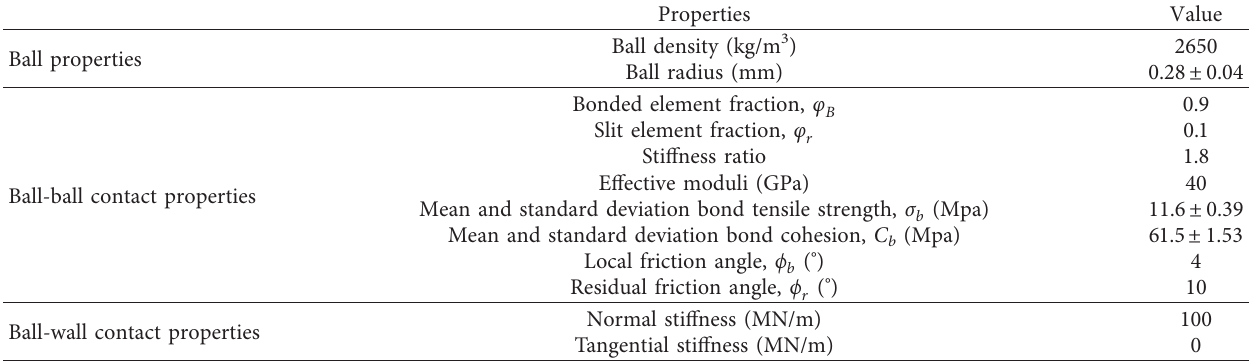
Table 1: Microproperties of balls and contacts [31].